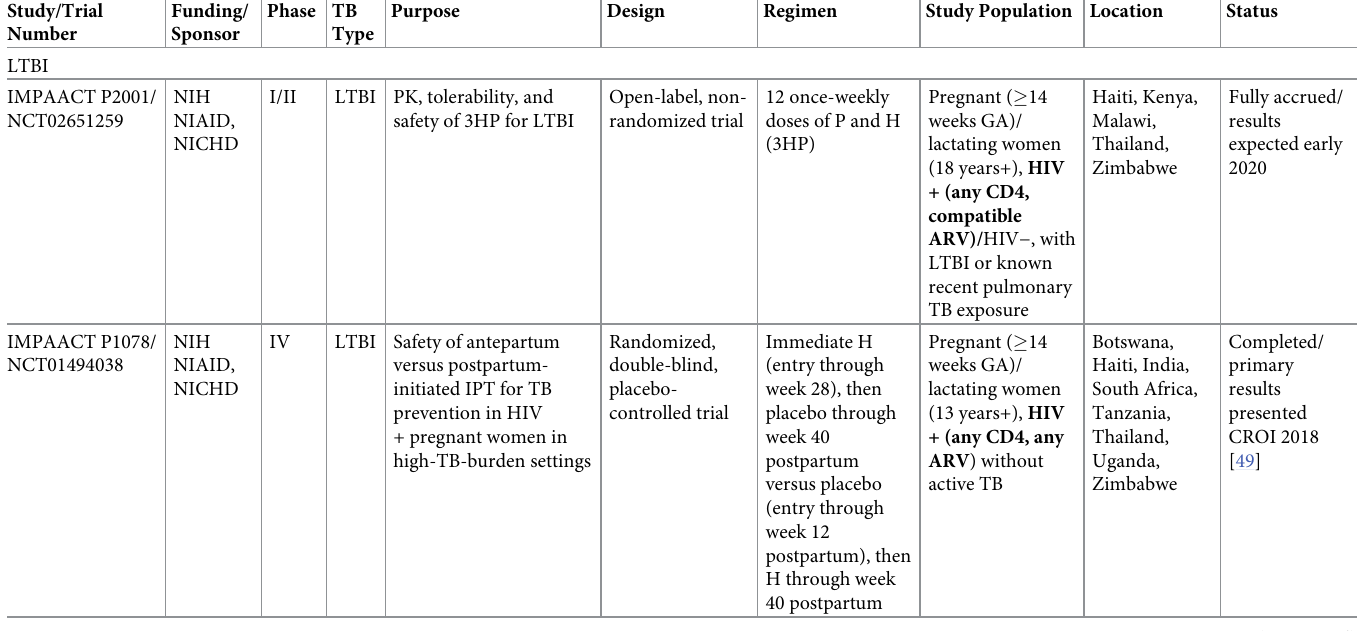
Table 2. Ongoing and planned clinical trials in pregnant and lactating women (as of December